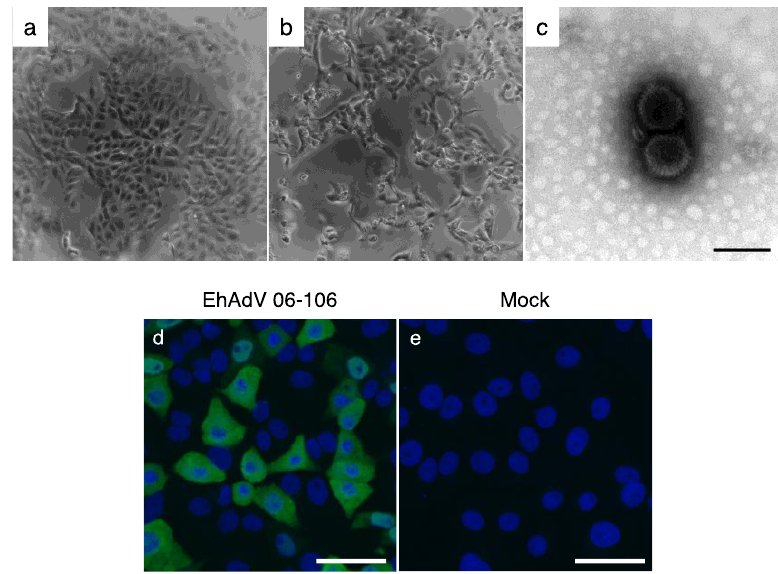
Figure 1. Isolation of E. helvum adenovirus (EhAdV) 06-106 with Vero E6 cells (upper panels). Control cells ( a ) and infected cells showing cytopathic effects ( b ); Transmission electron microgram of EhAdV 06-106 virions ( c ); Bar represents 100 nm. Detection of viral antigens in EhAdV 06-106-infected Vero E6 cells using anti-human adenovirus type 5 polyclonal antibody (lower panels). EhAdV 06-106-infected cells ( d ) and mock-infected cells ( e ); Nuclei of cells were stained with DAPI (4′,6-diamidino-2-phenylindole) (blue). Scale bars represent 50 μm.